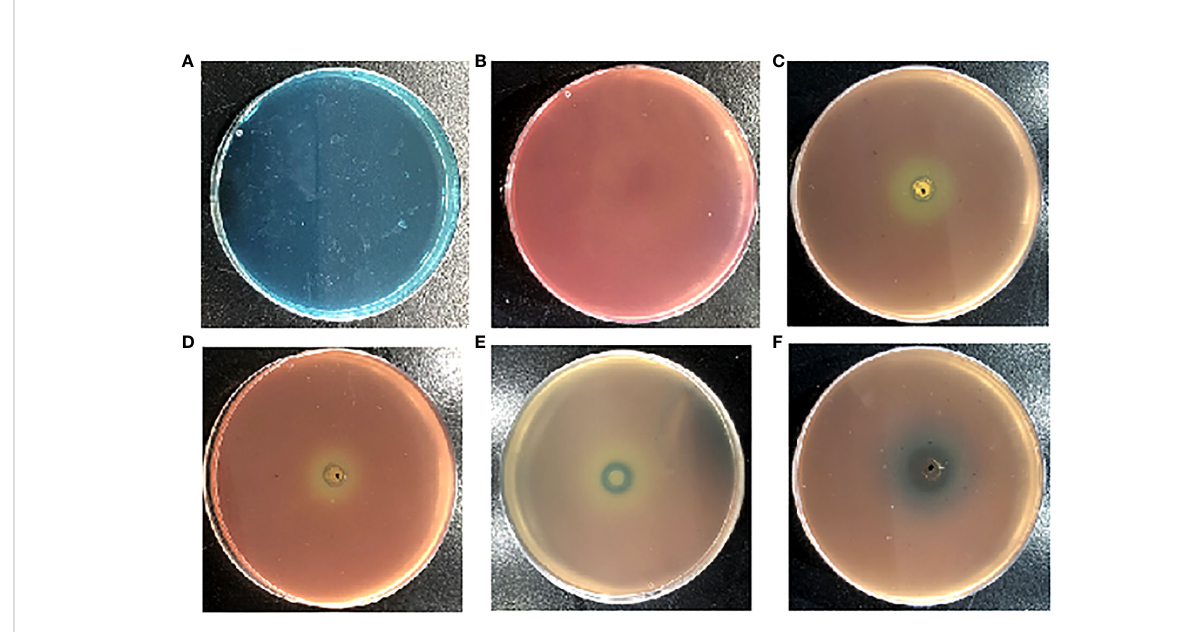
FIGURE 1 The effects of the different reported quorum sensing inhibitors (QSIs) on Pseudomonas aeruginosa PAO1 in Chromeazurol S (CAS) assays. The growth state of P. aeruginosa PAO1 in the CAS method (A) . The CAS method of pathogen-free growth (B) ; hordenine (C) ; resveratrol (D) ; N- methyl-3-phenyl-2-propen-1-amine (E) ; and (5Z)-4-bromo-5-(bromomethylene)-2(5H)-furanone (F) .